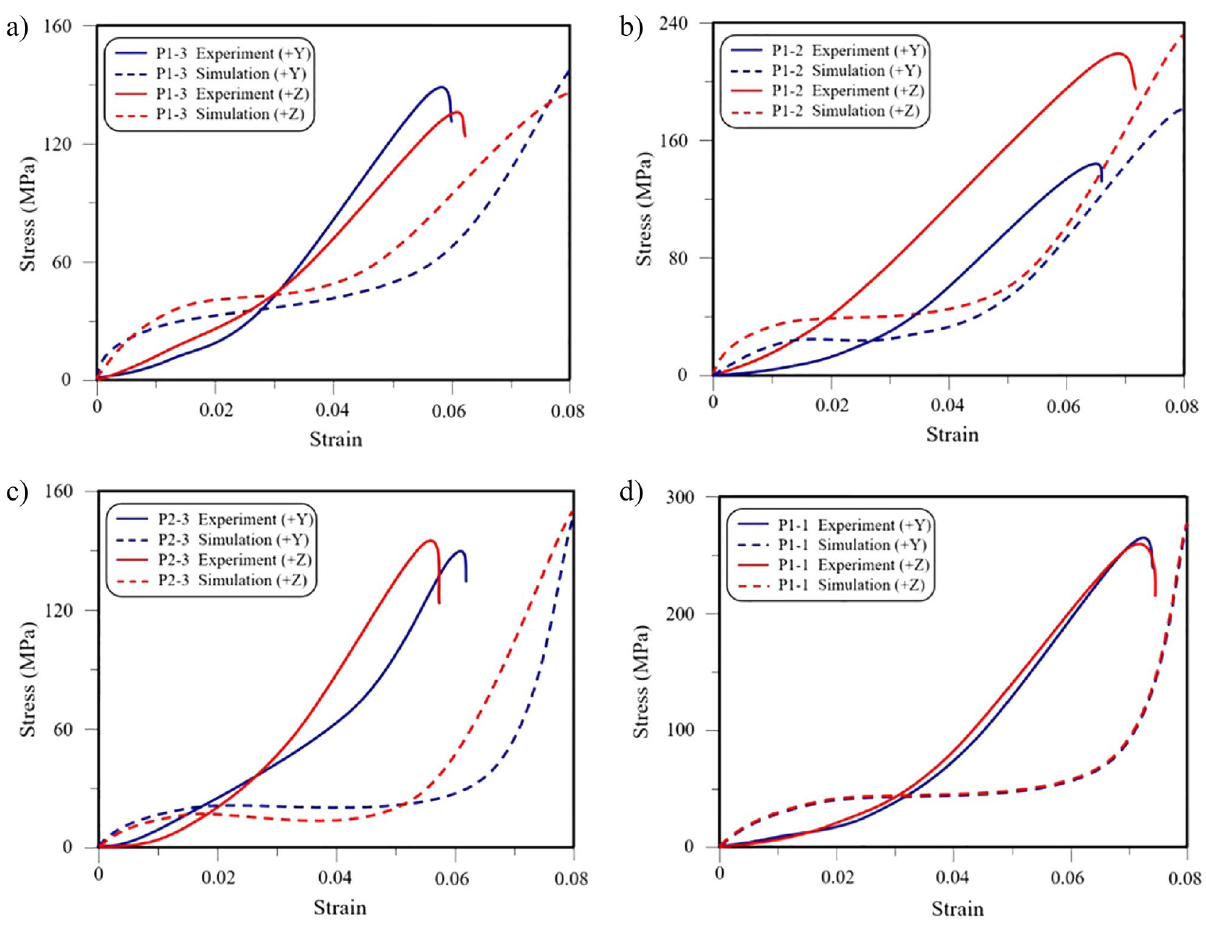
Figure 7. Stress–strain curve of scaffolds: ( a ) stress–strain curve by finite element simulation and compression test of P1-3; ( b ) stress–strain curve by finite element simulation and compress test of P1-2; ( c ) Stress–strain curve by finite element simulation and compress test of P2-3; ( d ) stress–strain curve by finite element simulation and compress test of P1-1.